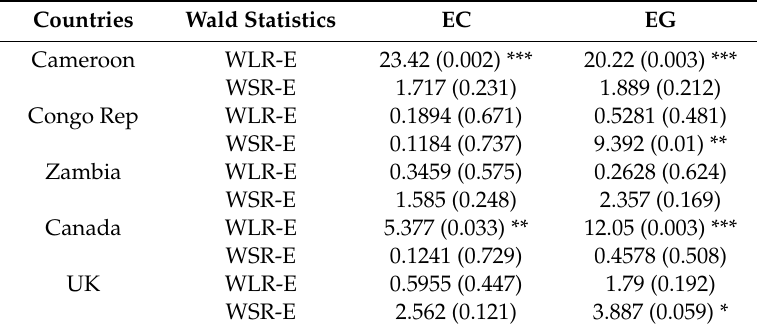
Table 9. Results for symmetry and asymmetry restrictions.